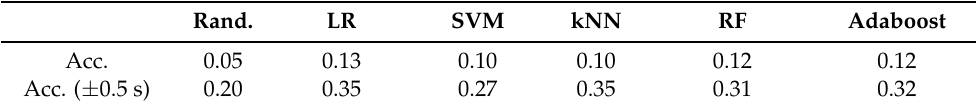
Table 3. Results of highlight start/classification for different models using accuracy.